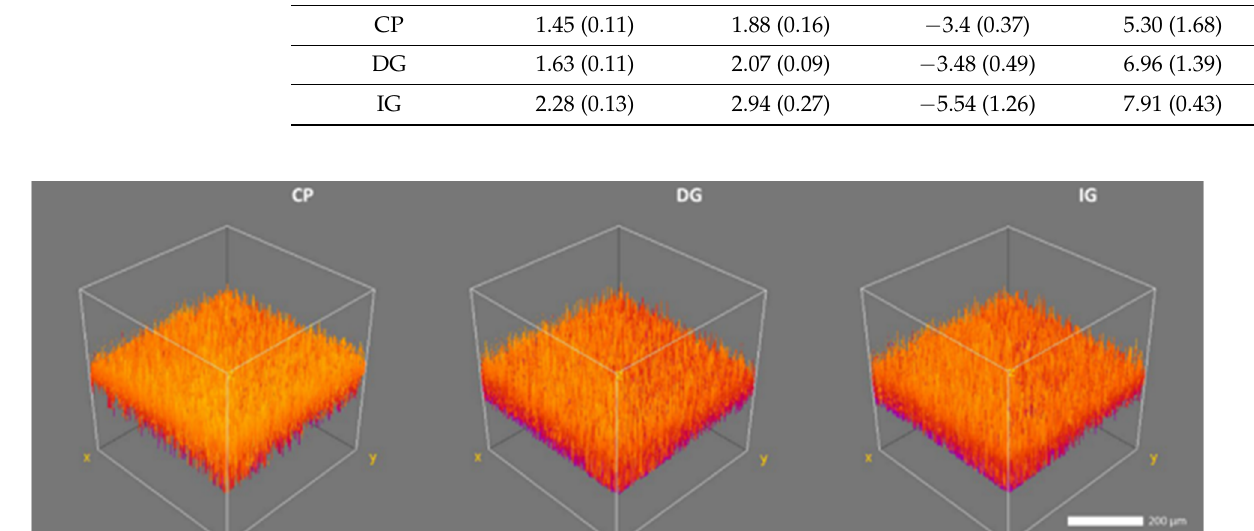
Figure 4. Three-dimensional representative CLSM images of specimens (group CP, DG, IG). Note the surface texture, crest and valley patterns of the specimen surfaces.